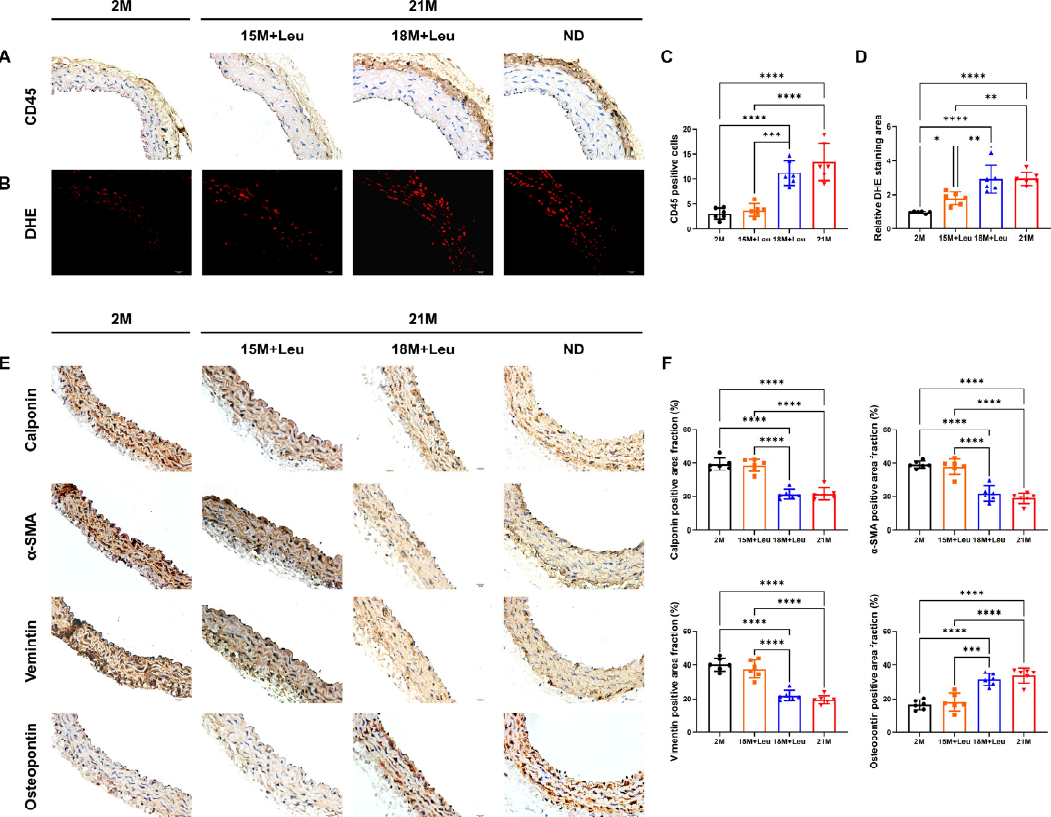
Figure 3. Leucine supplementation from 15M relieved aging-induced vascular inflammatory re- sponses, ROS generation, and VSMC phenotype transformation. Representative images of CD45 immunohistochemistry staining showed inflammatory cell infiltration ( A ). Representative images of DHE staining ( B ). Quantitative analysis of CD45 positive cells is shown in ( C ). Quantitative analysis of the red dots is shown in ( D ). Representative immunohistochemistry staining and quantification of contractile markers calponin, α -SMA, vimentin, and synthetic marker osteopontin are shown in ( E , F ). Statistical analysis was performed using one-way ANOVA; data are presented as mean ± SEM, n = 6/group. * p <0.05, ** p < 0.01, *** p < 0.001, and **** p < 0.0001. ND: normal diet.